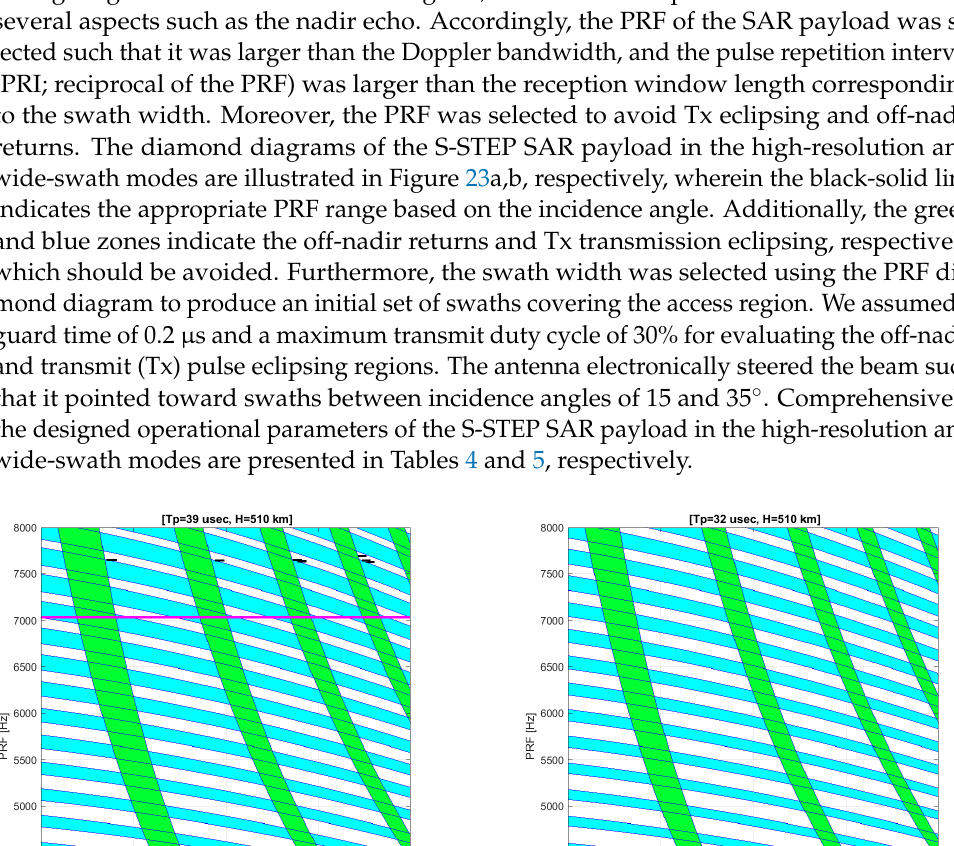
Table 5. Operational parameters of the S-STEP SAR payload in the wide-swath mode.